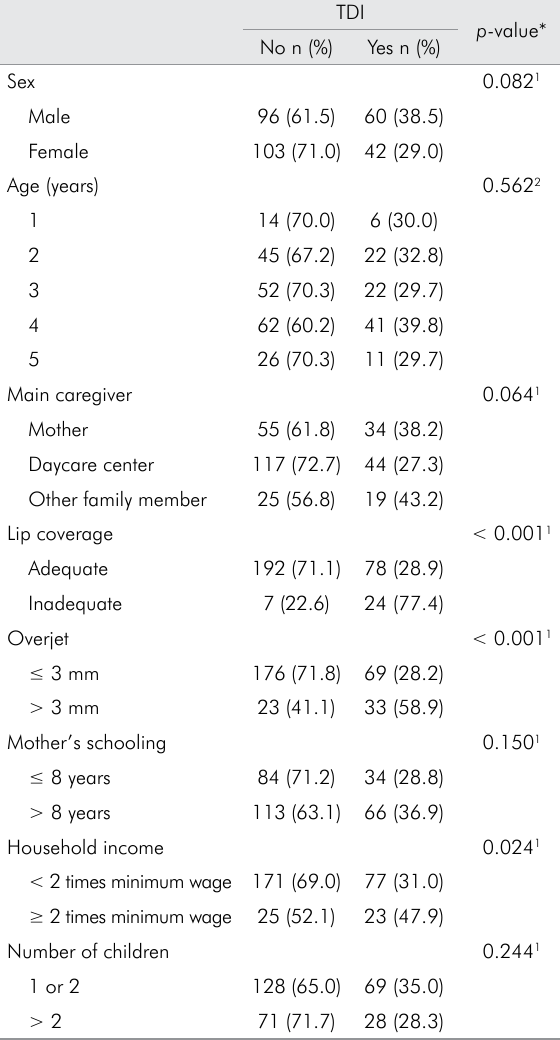
Table 2. Distribution of TDI according to characteristics of the child, socioeconomic indicators and clinical variables.